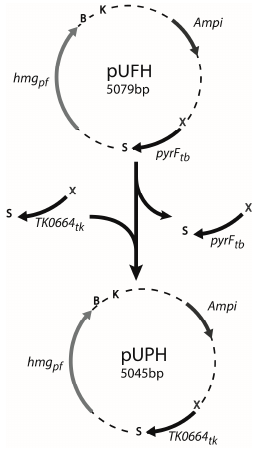
Figure 1. Construction of the pUPH plasmid. Primers XhoI-6MPK_Up and SmaI-6MPK_Do were used to amplify TK0664 from the T. kodakarensis KOD1 genome. Then, TK0664 and the vector pUFH were digested by SmaI (S) and XhoI (X) and ligated after a gel purification step, to form plasmid pUPH where pyrF is replaced by TK0664 . The restriction sites BamHI (B) and KpnI (K) were conserved to enable cloning of the homologous regions in pUPH.